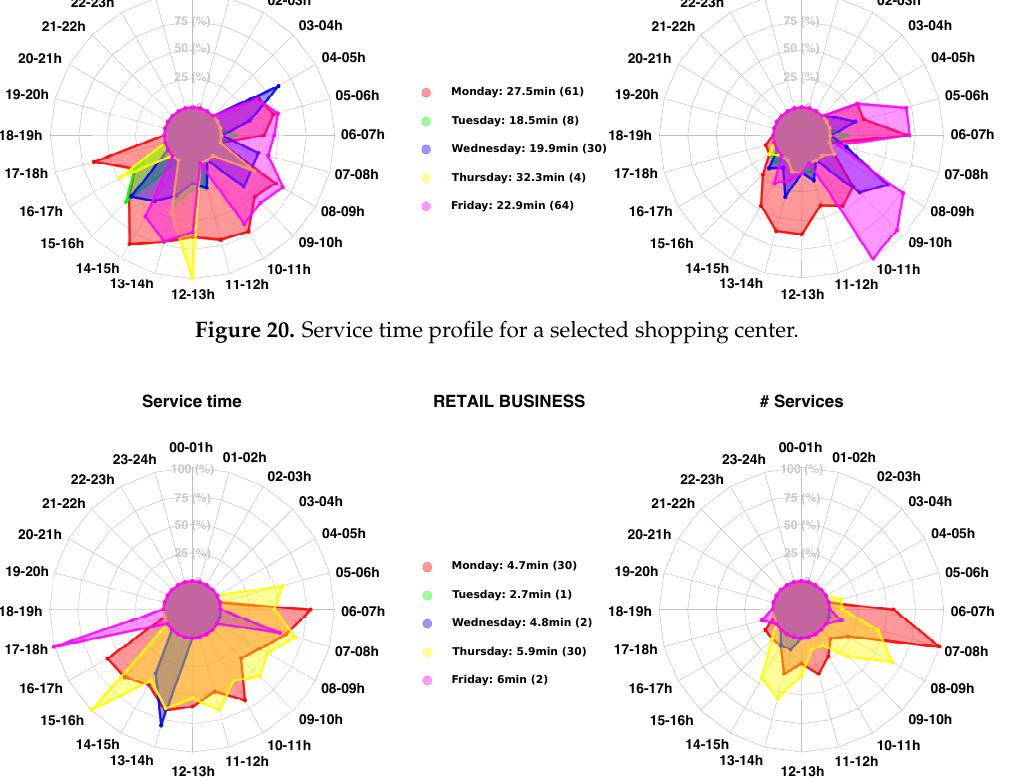
Figure 21. Service time profile for a selected retail